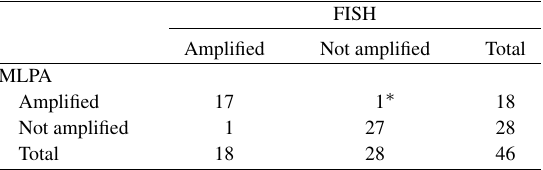
Comparison of FISH and MLPA for detection of Her-2/neu amplifi- cation in 46 breast